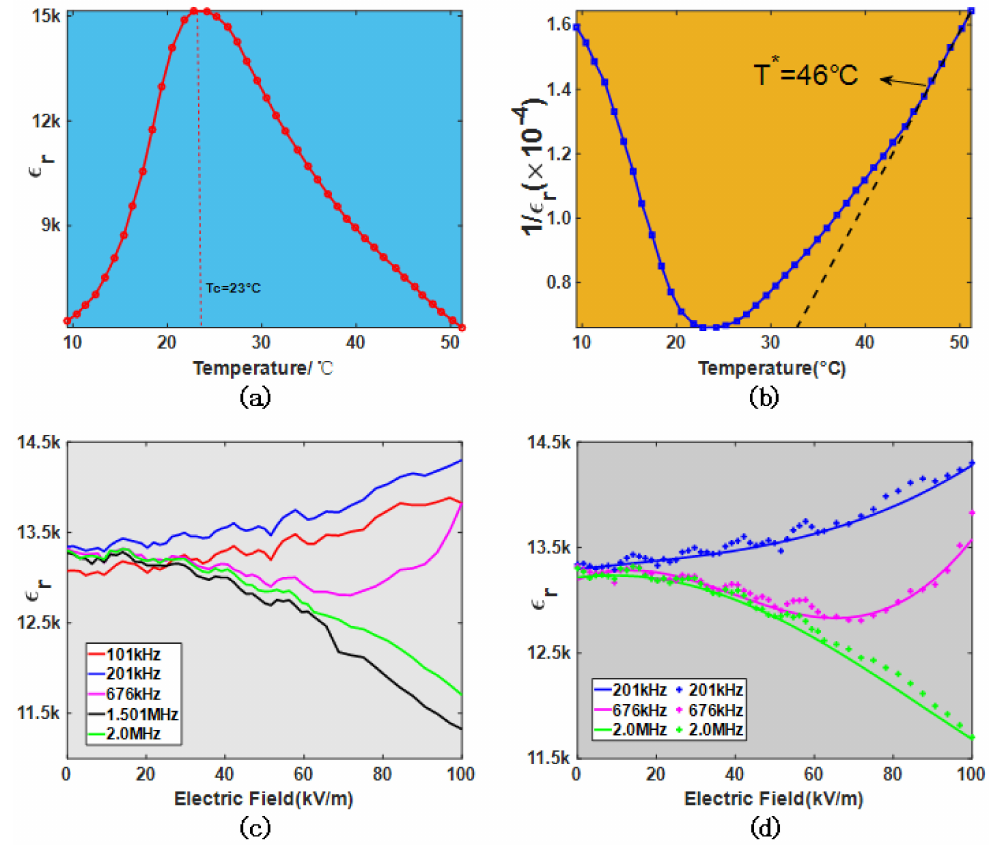
Figure 3. The temperature dependence of the dielectric permittivity ( a ) ε r and impermeability ( b ) 1/ ε r . ( c ) The frequency dependence of the dielectric response to the bias electric field. The red dotted line indicates the Curie temperature, the black dotted line represents the Curie-Weiss law, and the black arrow indicates the intermediate temperature. ( d ) Fitting result at 201 kHz, 676 kHz, and 2 MHz. The plus sign indicates the experimental data, and the solid line represents the result fitted by Equation